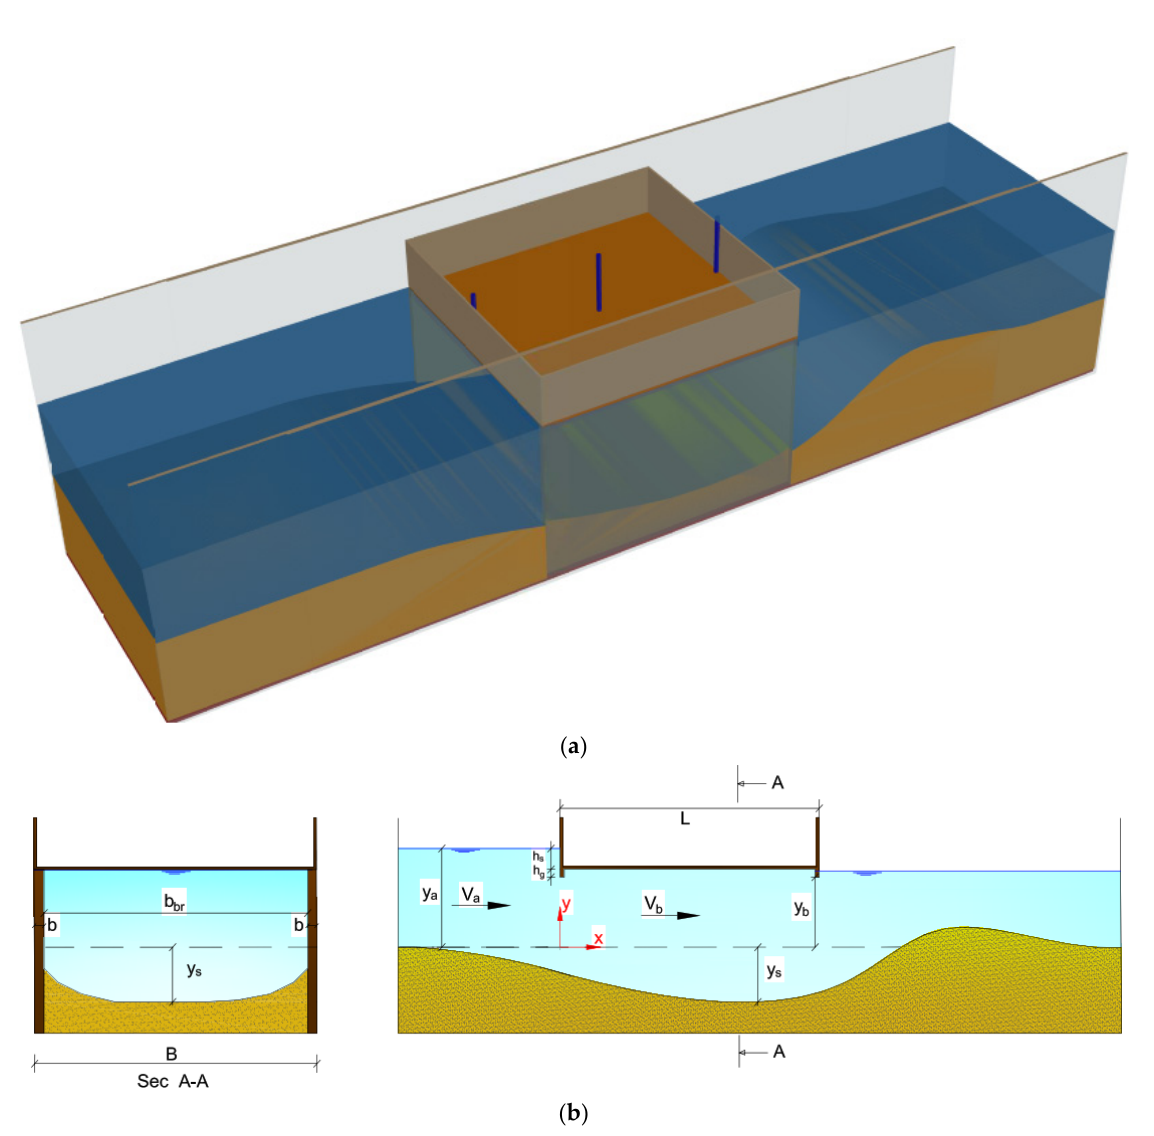
Figure 2. Definition diagram for tested apparatus: ( a ) 3D view; ( b ) side view and sec A-A. Table 2. Values of experimental parameters.